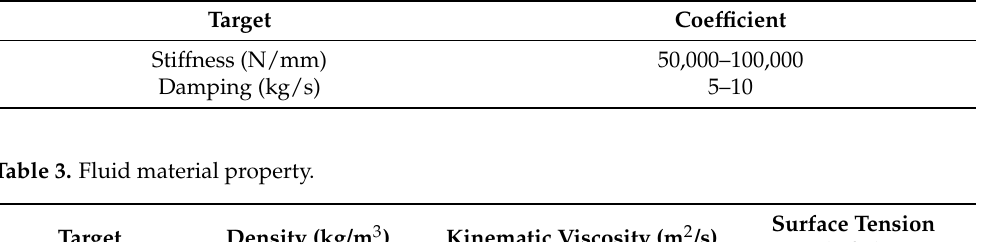
Table 2. Contact conditions.